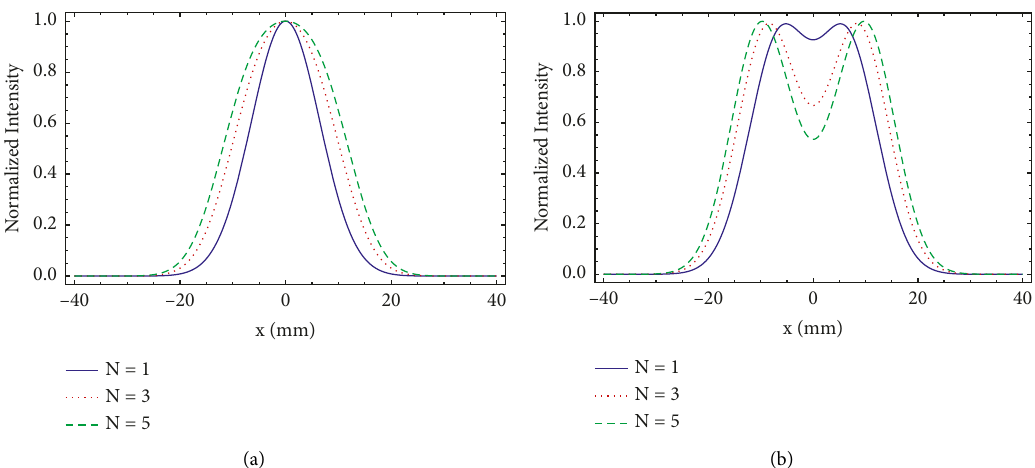
Figure 7: Cross-sections of the intensity distribution of the partially coherent circular: (a) flat-topped nonvortex beam and (b) flat-topped vortex hollow beam in anisotropic turbulent plasma for different values of the order of the circular flat-topped beam N ( z